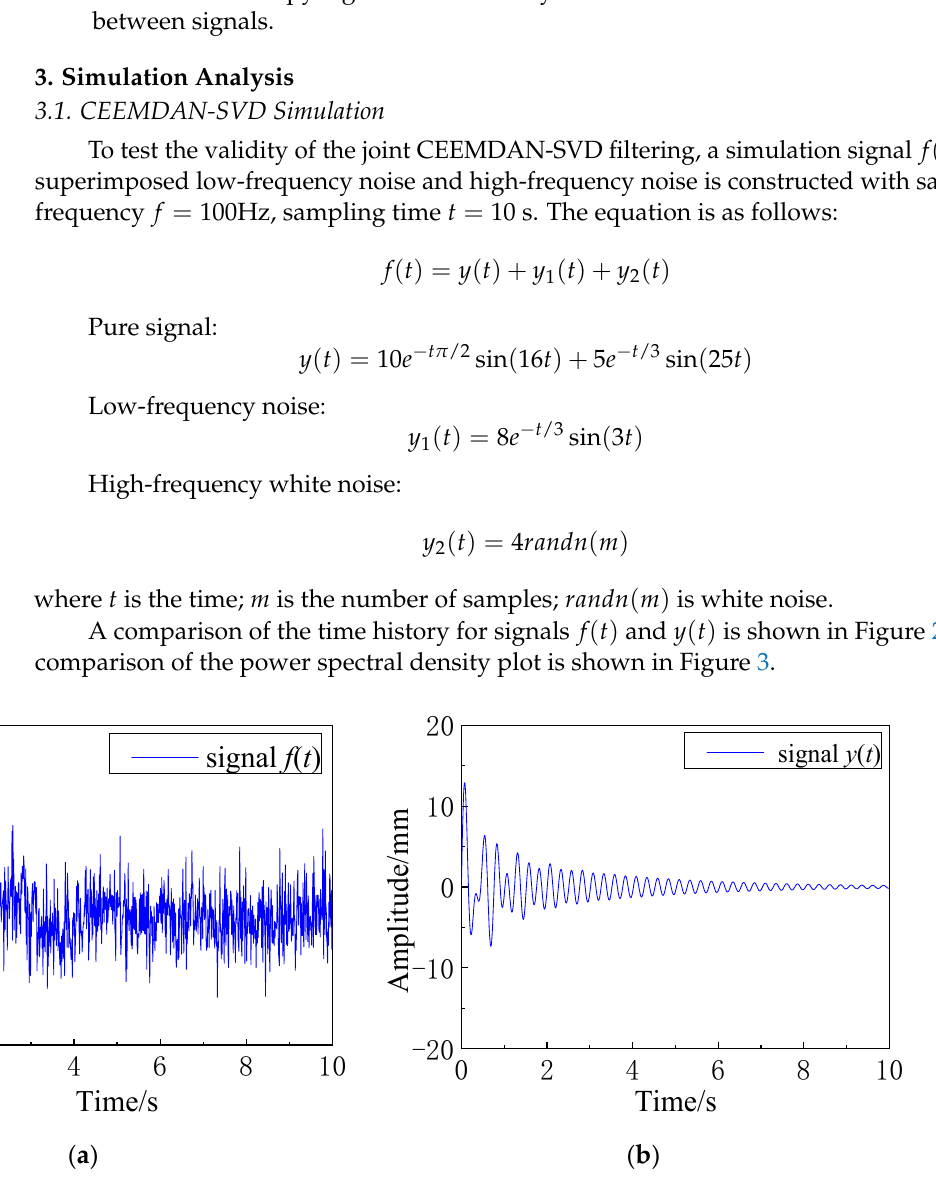
( ) f t ( ) y t and pure signal . ( a ) Time his- ( ) y t .